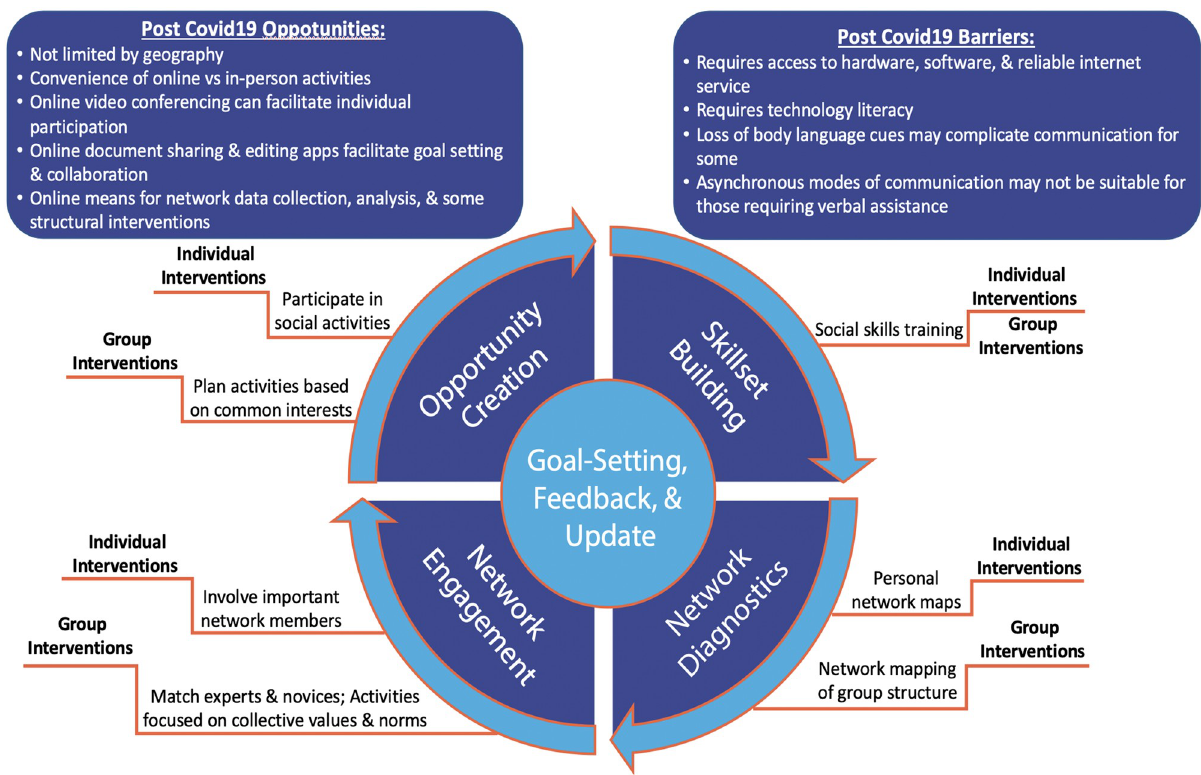
Fig 2. Components of individual- and group-level network-building interventions; opportunities and barriers for post-COVID19 adaptation.